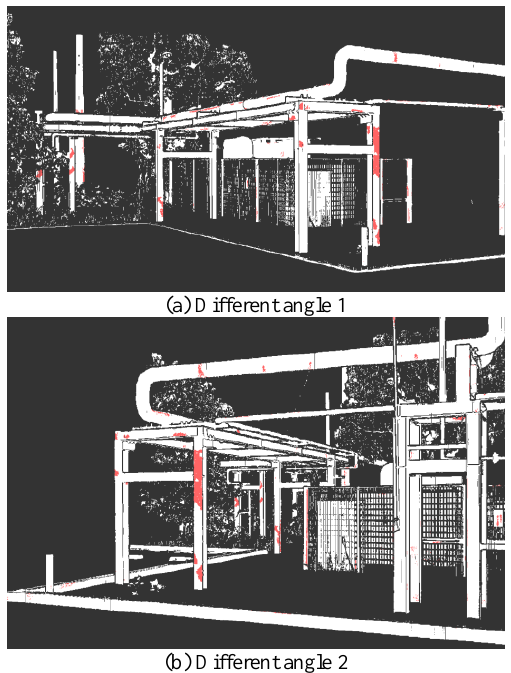
Figure 11. Detection results by proposed method for scene in Figure